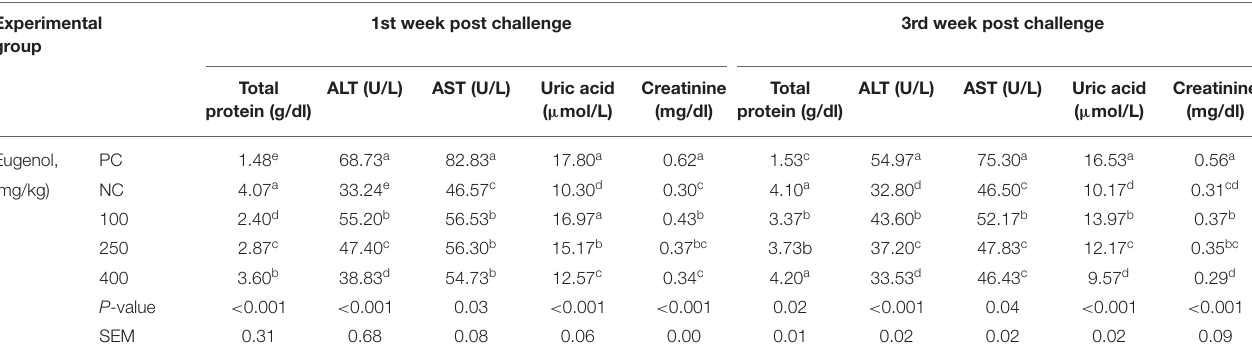
TABLE 5 | Effects of dietary supplementation of various concentrations of eugenol nanoemulsion on serum biochemical parameters of broilers post-challenge with E. coli O78. Experimental